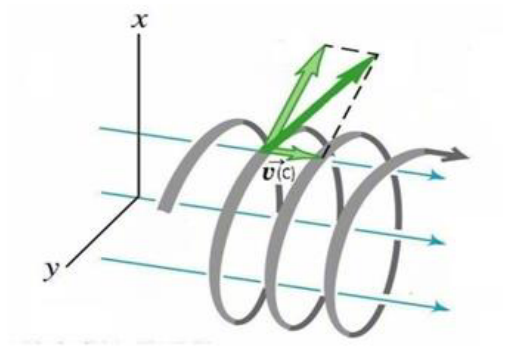
Fig. 1. 3 dimensional motion of photon